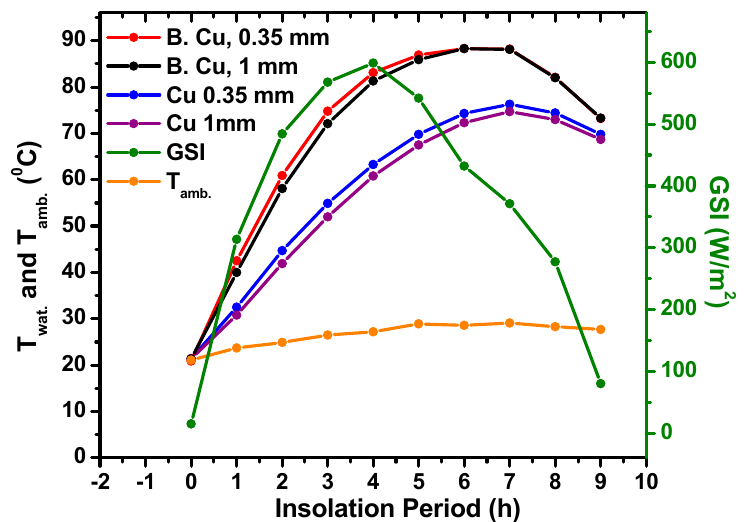
Figure 6. Water and ambient air temperatures (T wat . and T amb .) and global solar intensity (GSI) against insolation period, Cu and B. Cu containers with two thicknesses, 0.35 mm and 1 mm; starting time: 8:00 a.m.; partially cloudy weather; date: 14/10/2021, Amman, Jordan.